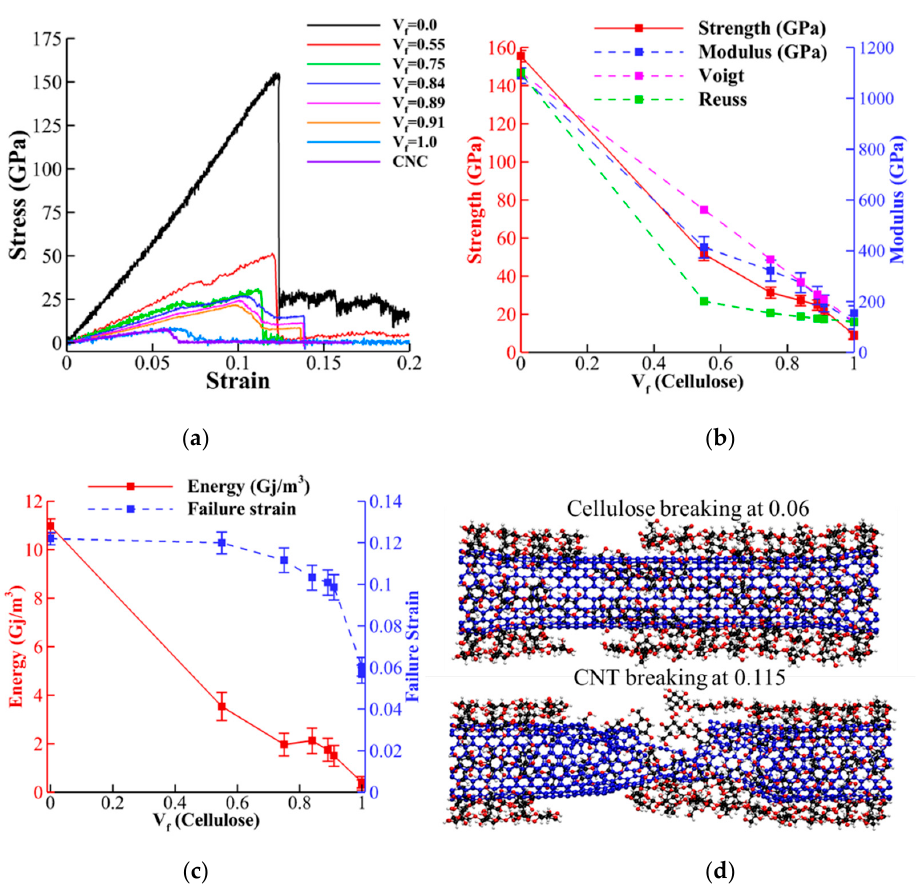
Figure 5. Mechanical properties of CNT-wrapped cellulose at different cellulose contents. ( a ) Represents stress-strain curves. ( b ) Variation of strength and Young’s modulus for different cellulose content is shown. ( c ) Variation of toughness and failure strain for different cellulose content is shown. ( d ) Fractured model for single walled cellulose ( Vf = 55%) shows cellulose chains breaking at 6% strain and then nanotube fails at 0.125 strain.